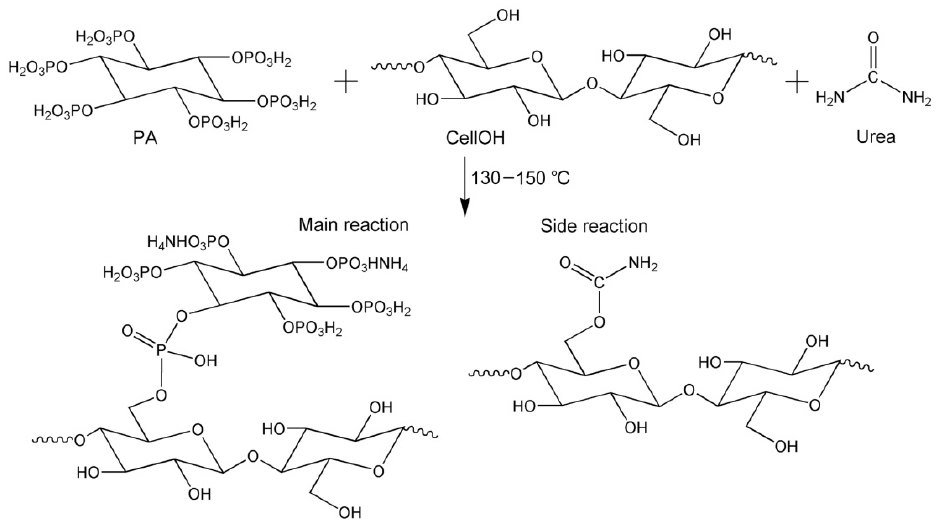
Figure 5. Schematic diagram of the phosphorylation of KF with PA in the presence of urea.